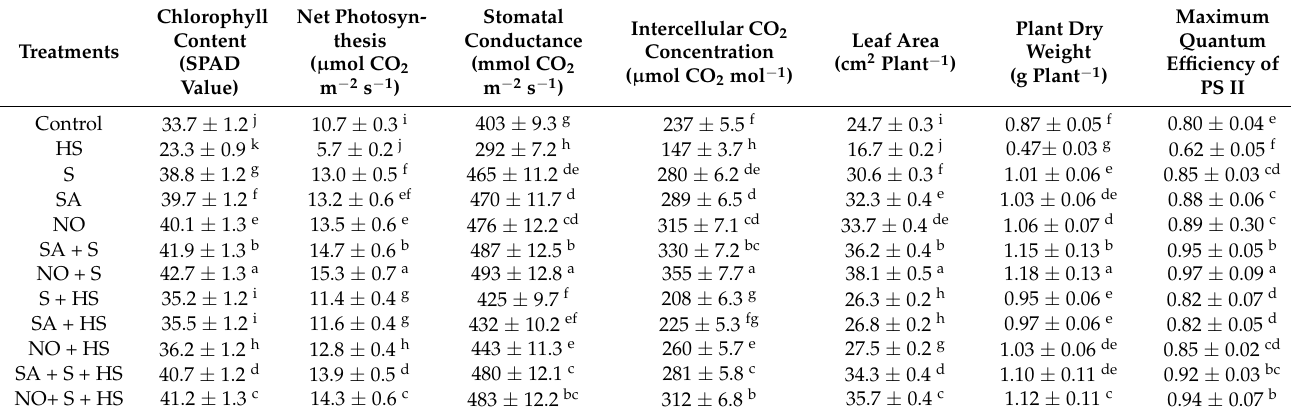
Table 2. Chlorophyll content (SPAD value), net photosynthesis, stomatal conductance, intercellular CO 2 concentration, leaf area, plant dry weight and maximum quantum efficiency of pigment system (PS) II of wheat ( Triticum aestivum L.) cv. HD-3226 treated with 0.5 mM salicylic acid (SA)